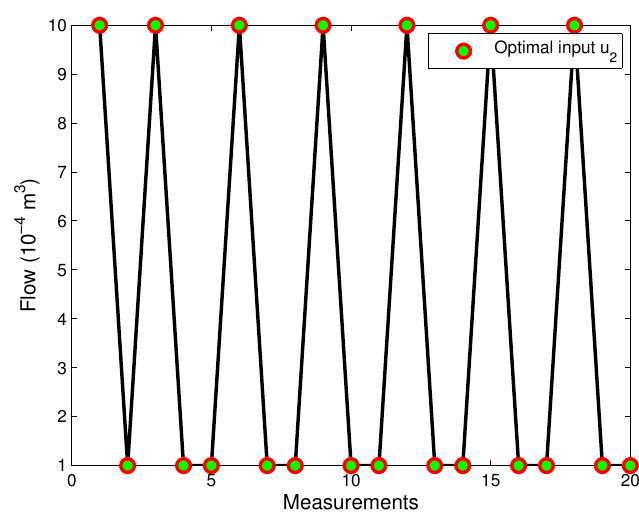
Figure 14. D-optimum pump control signal u 2 .